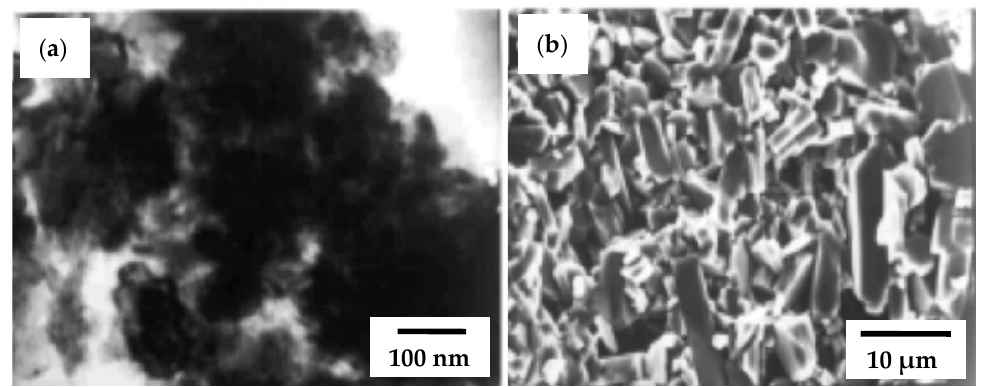
Figure 10. TEM image of SHS TiB 2 powder ( a ) and SEM fracture of TiB 2 pellet sintered at 2123 K ( b ). Reprinted from Khanra et al., 2005 with copyright permission, Journal of the American Ceramic Society [69].